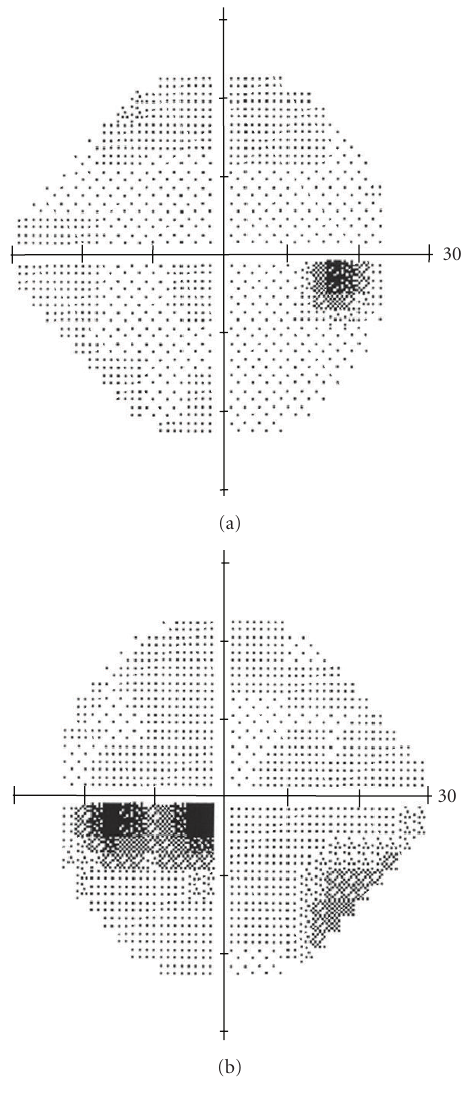
Figure 2: Normal visual field examination in RE (a) Visual field examination with an enlargement of the blind spot and presence of horizontal inferior papillomacular scotoma in LE (b).